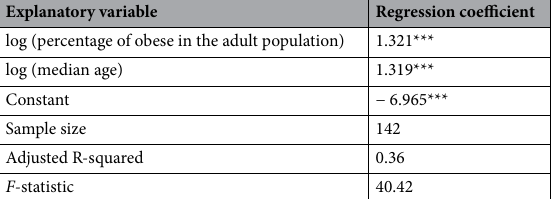
Explanatory variable Regression